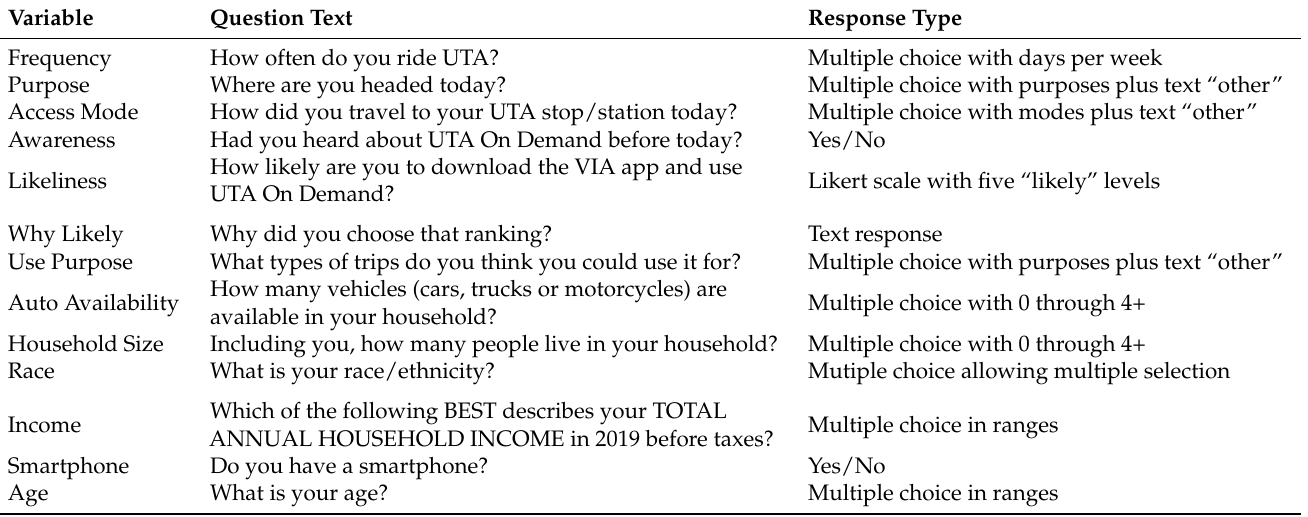
Table 1. Survey Questionnaire